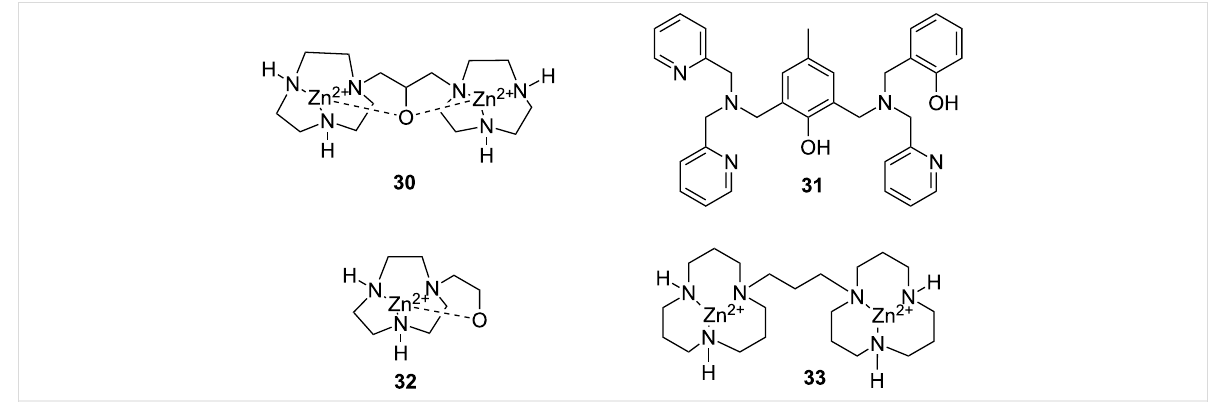
Figure 12: Miscellaneous complexes and ligands used in kinetic studies of metal-ion-promoted cleavage of nucleic acids.